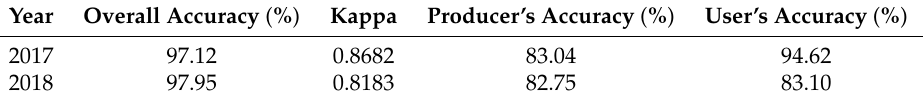
Table 3. Confusion matrix of classification result for aquatic vegetation (Compared to Sentinel-2).